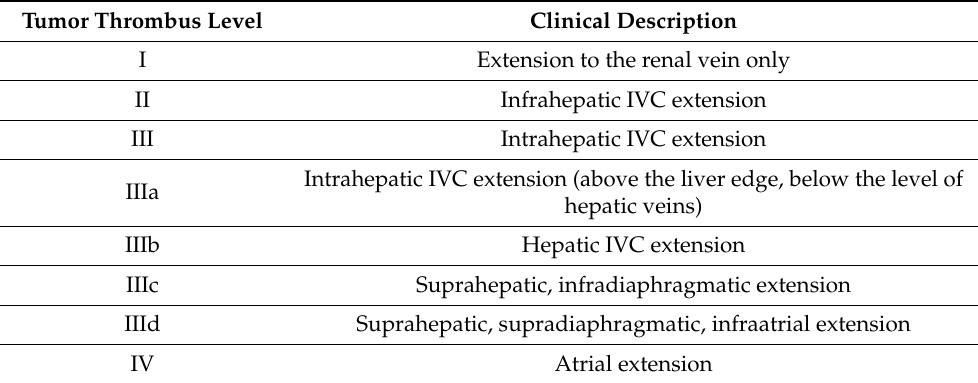
Table 2. IVC tumor thrombus level in